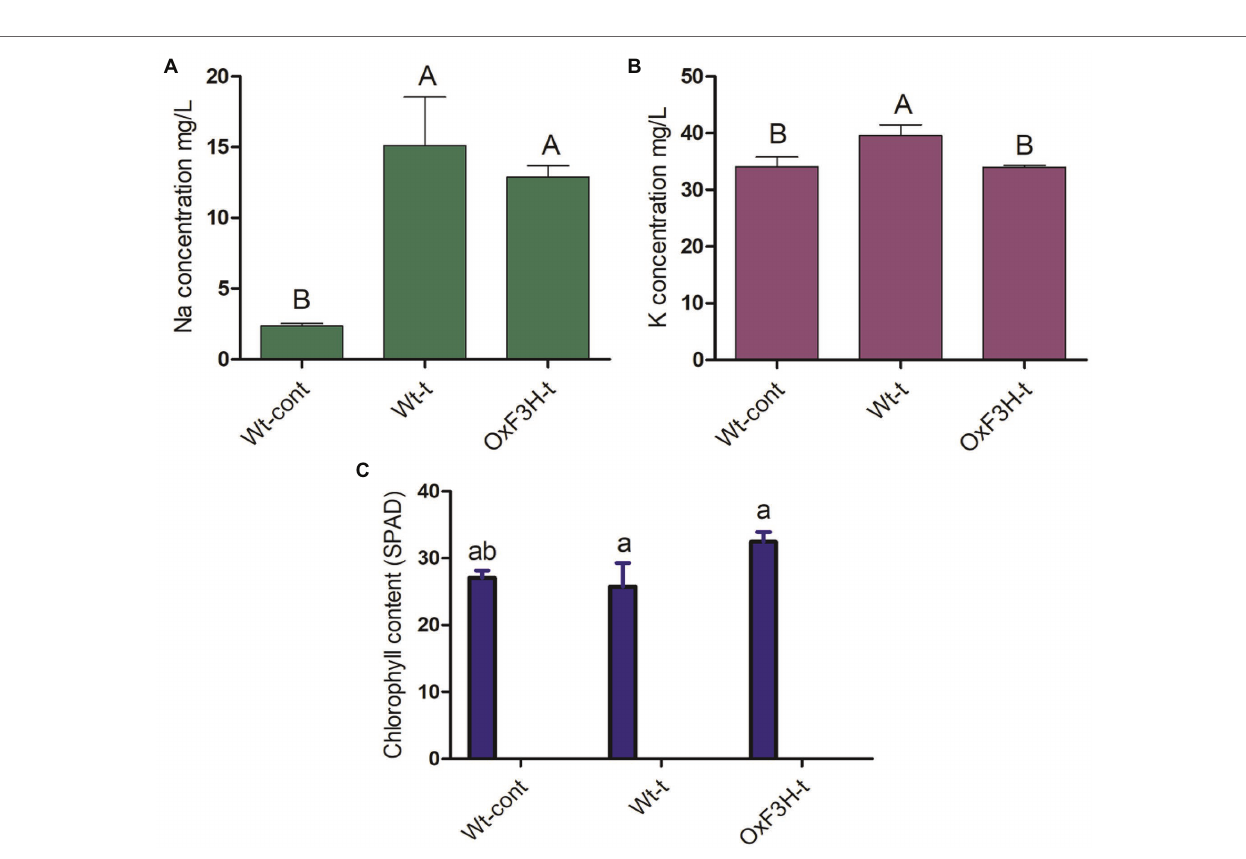
FIGURE 6 | Na+, K+, and chlorophyll accumulation in plants under combined salt and heat stress. (A) Na+ concentration, (B) K+ concentration, and (C) chlorophyll content. Different letters on the bars represent significant differences (p ≤ 0.001) as determined by Duncan’s multiple range tests.